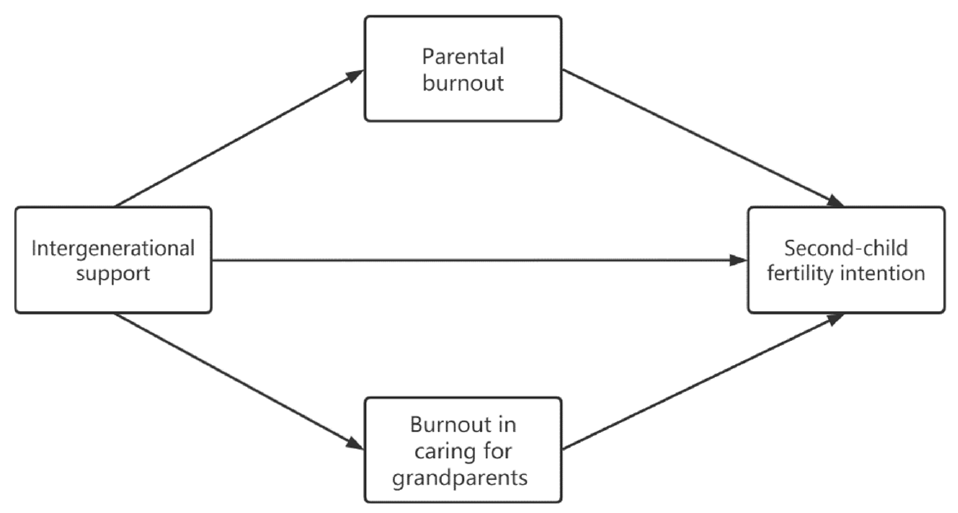
Figure 1. Proposed Model.